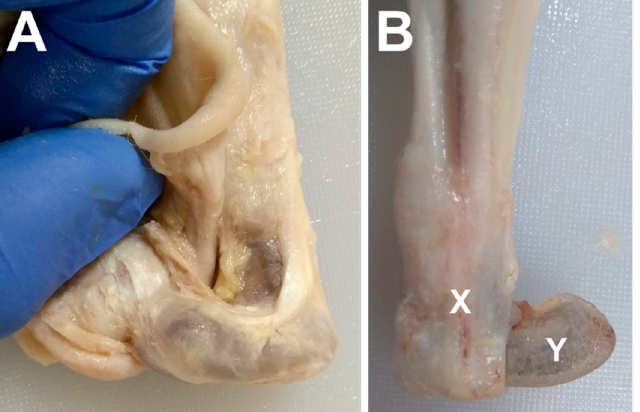
Figure 5. Fibrous encapsulation of endoprosthesis on ( A ) rabbit E2 and ( B ) rabbit E3, with “X” indicating the in situ encapsulation and “Y” indicating the endoprosthesis with the encapsulation re- moved. All three rabbits exhibited encapsulation around the endoprosthesis.